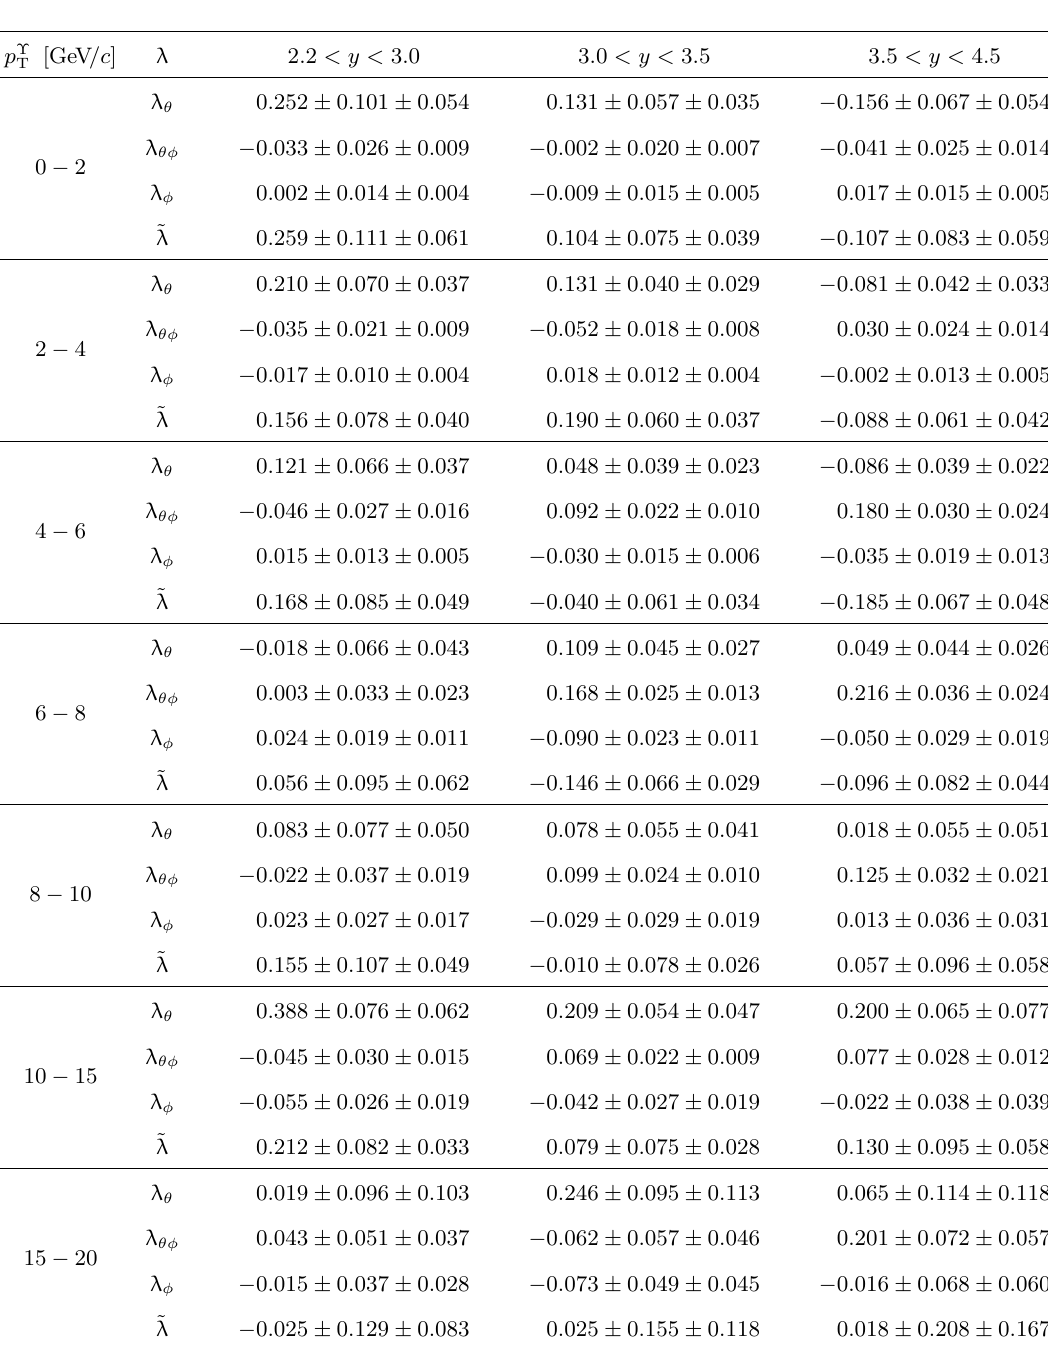
Table 12 . Values of (cid:21) (cid:18) , (cid:21) (cid:18)(cid:30) , (cid:21) (cid:30) and ~ (cid:21) measured in the HX frame for the (cid:7)(2S) produced at p s = 8 TeV. The (cid:12)rst uncertainty is statistical and the second systematic.